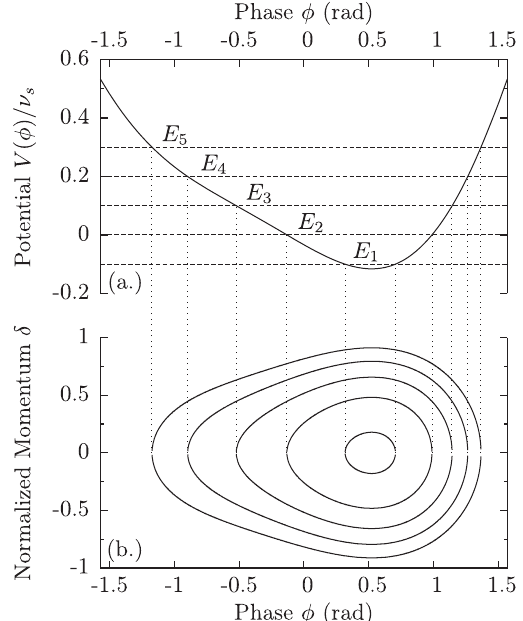
with varying Δ ϕ . o o